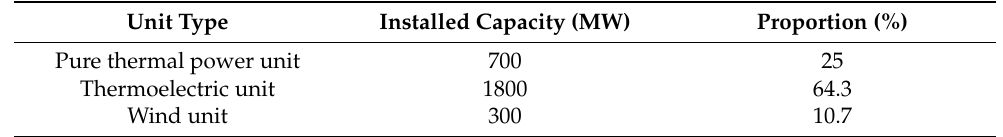
Table 6. Installed capacity and